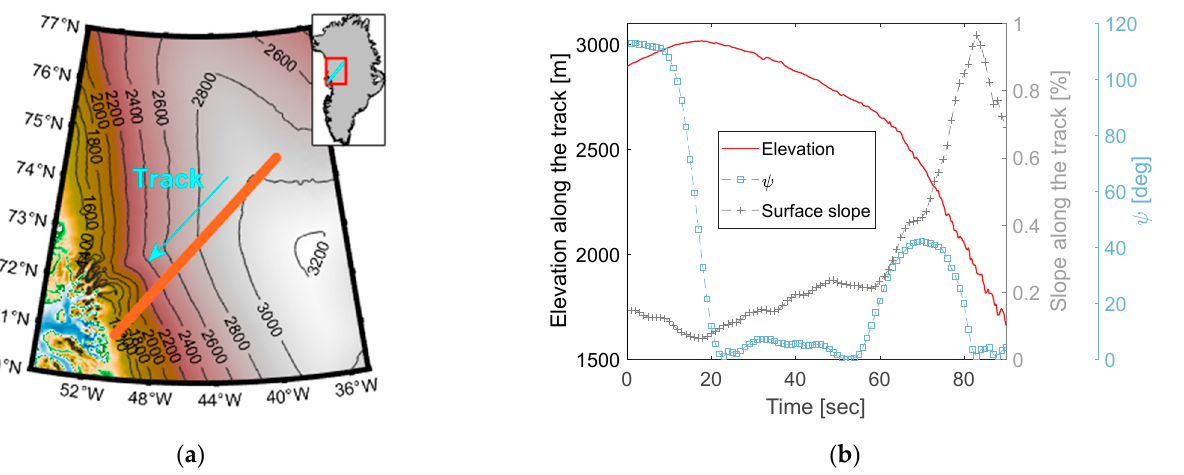
Figure 5. The errors of specular points correspond to different surface slopes and aspects. Horizontal shifts ( a ) and height shifts ( b ) of specular points versus the surface slopes in three slope aspect situ- ations corresponding to the same path range of reflected signal from the ellipsoidal surface.